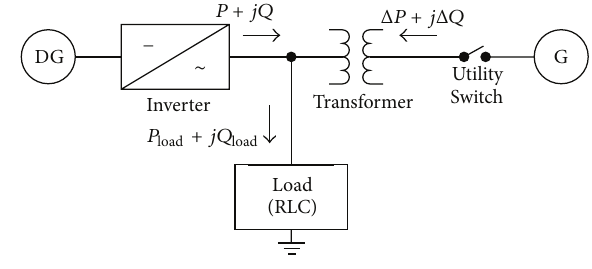
Figure 1: Power balance of the system.